Question: What visual encoding does this figure use to show its data?
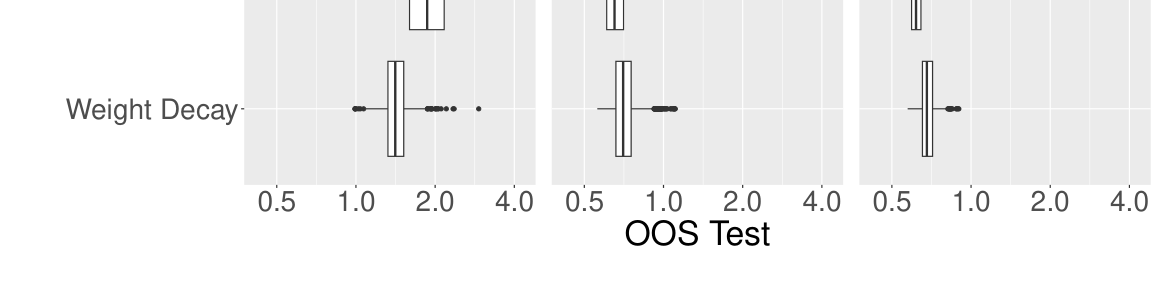
Answer: box